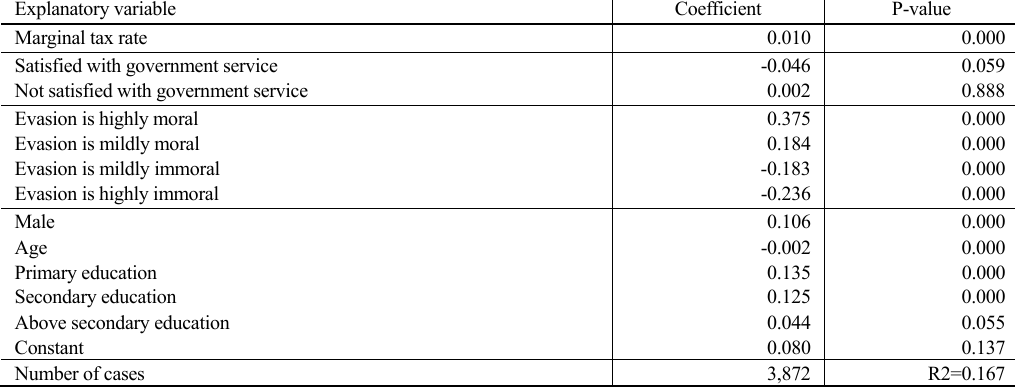
Table 3 : Regression of Whether or Not an Individual Evaded on Tax, Public Choice, and Demographic Variables for Pooled 2000, 2002, 2004, 2006 Czech Surveys.